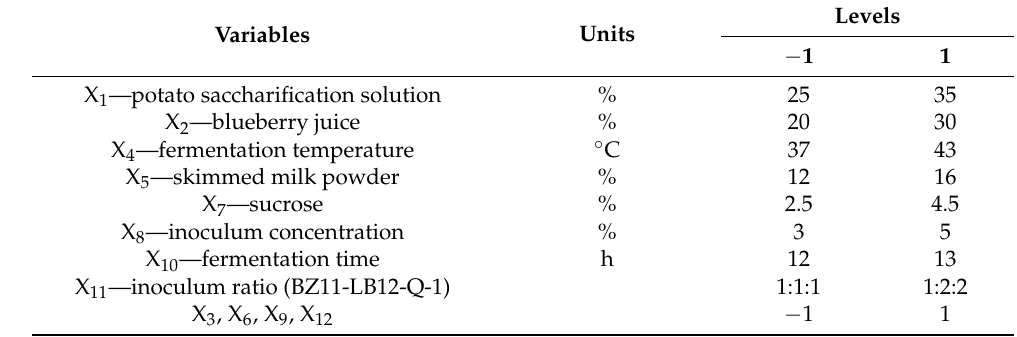
Table 1. PB design factors and